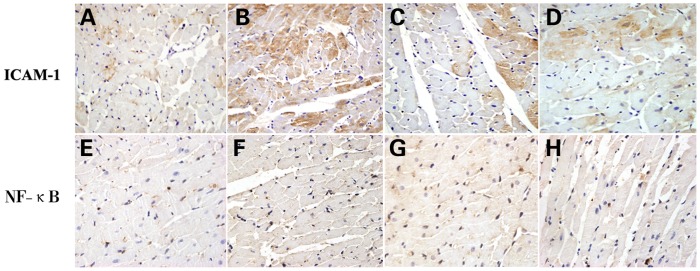
Immunohistochemistry staining of ICAM-1 and NF-κB p65 in the heart.A,E: NC group (n = 10); B,F: MS group (n = 10); C,G: MS+A group (n = 11); D,H: MS+H group (n = 11). The panels showed representative images of micrographs of immunohistochemistry staining in 4 groups. Original magnification, ×400.